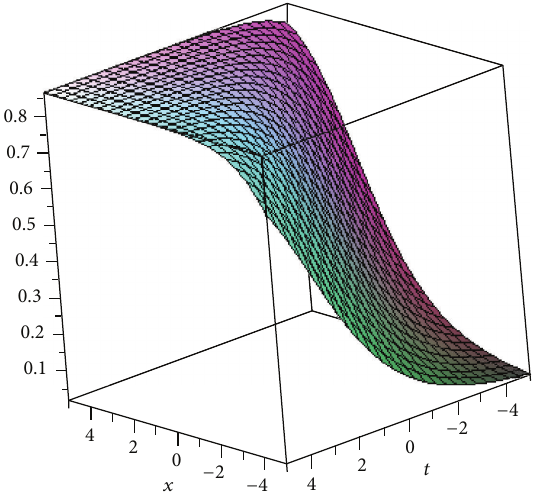
Figure 1: The plot of solution (24) with 𝛽 = 𝑅 = 1 , 𝜇 = 𝑛 = 2 , and 𝛾 = −1 .